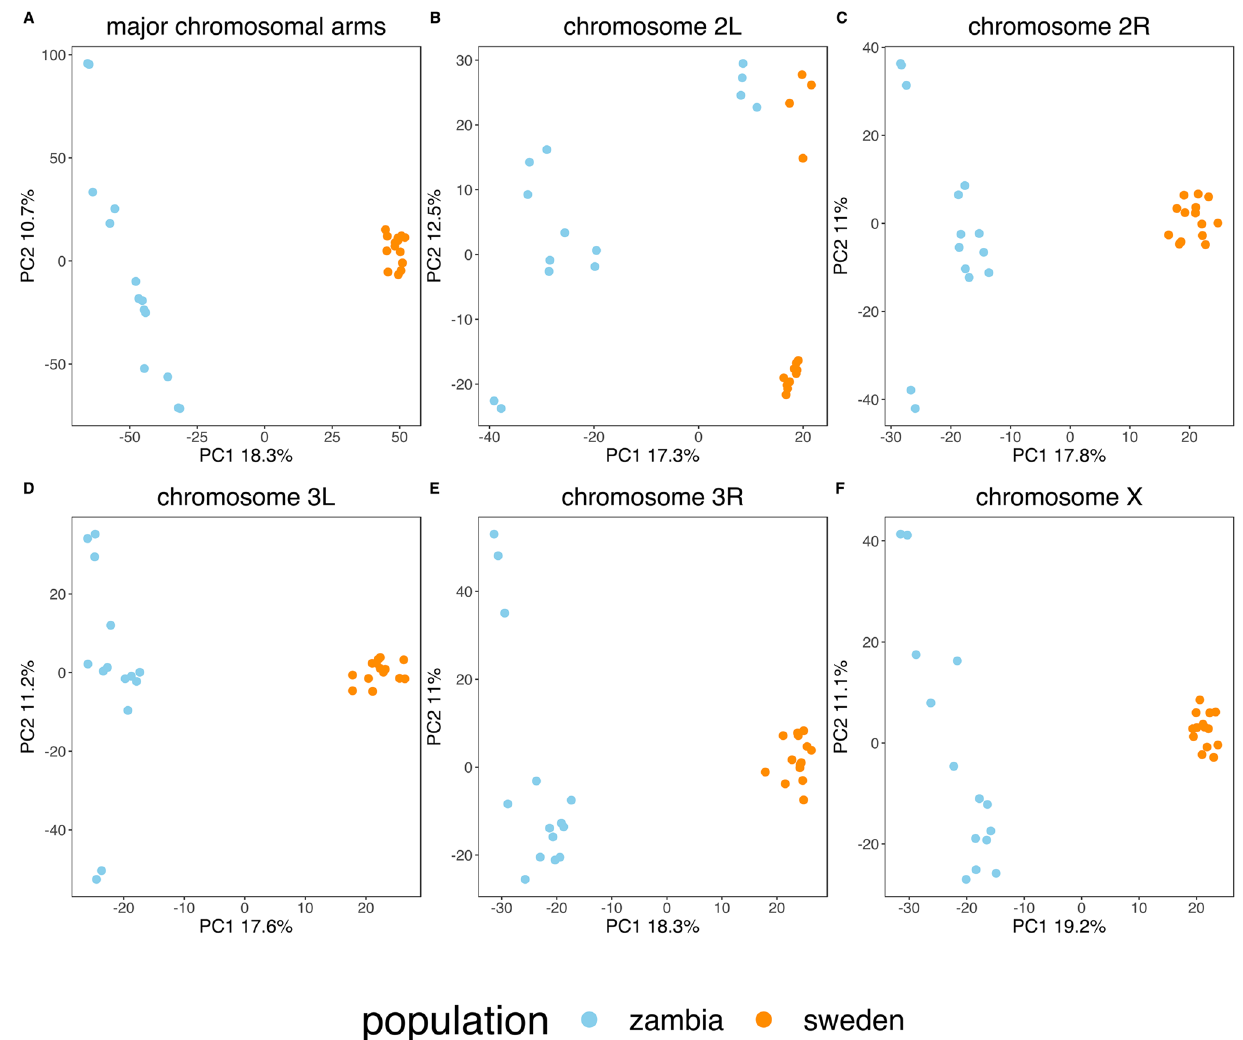
Figure 1. PCA results. Results are presented for each major chromosomal arm separately and for all chromosomes together. Only the first two components are shown. Individuals tend to cluster according to their sampling location ( A , C – F ) except for chromosome 2L ( B ), for which the inversion In(2L)t creates an additional level of